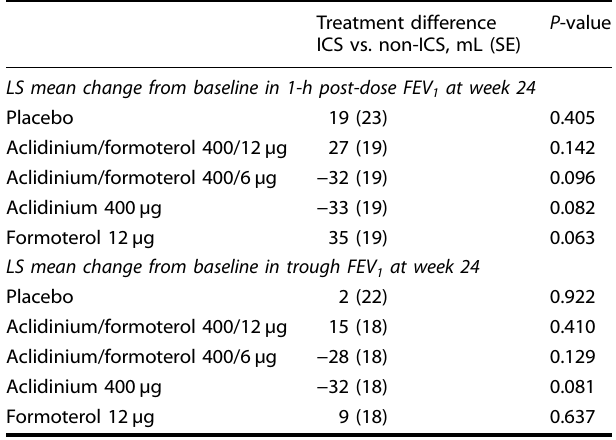
Table 3. Lung function end points: ICS users vs. non-ICS users